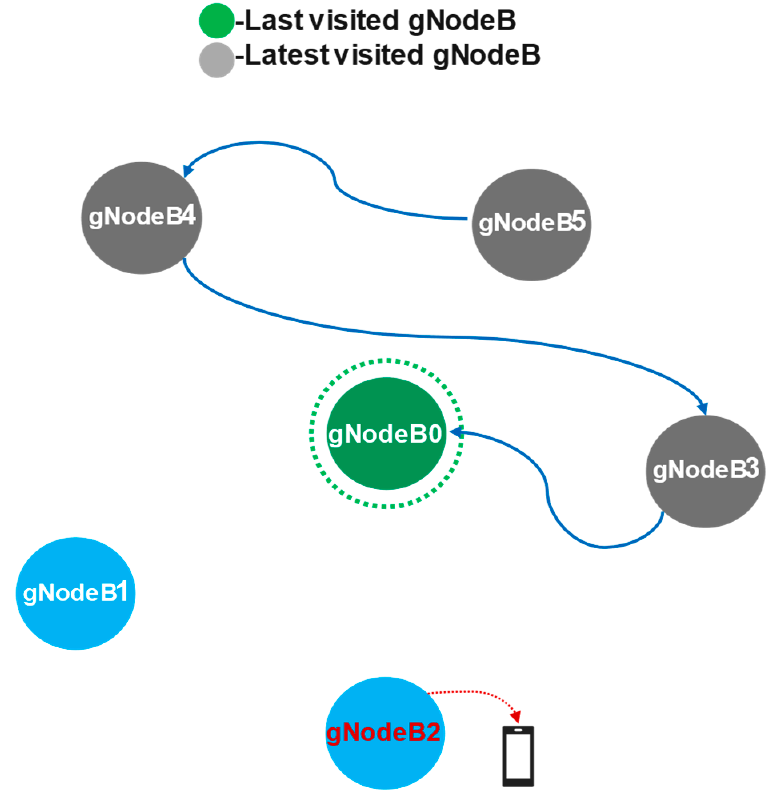
Figure 4. Example of paging on latest gNodeB list.